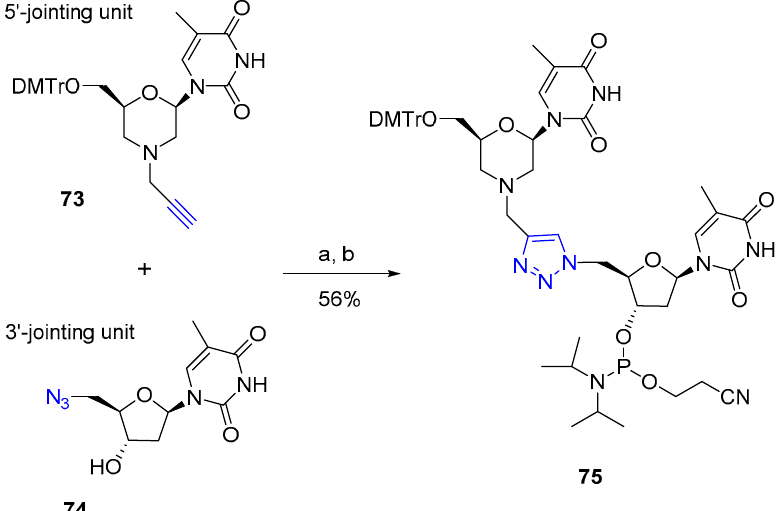
Scheme 18. Synthesis of the triazole-linked morpholino dinucleotide. Reaction conditions: ( a )